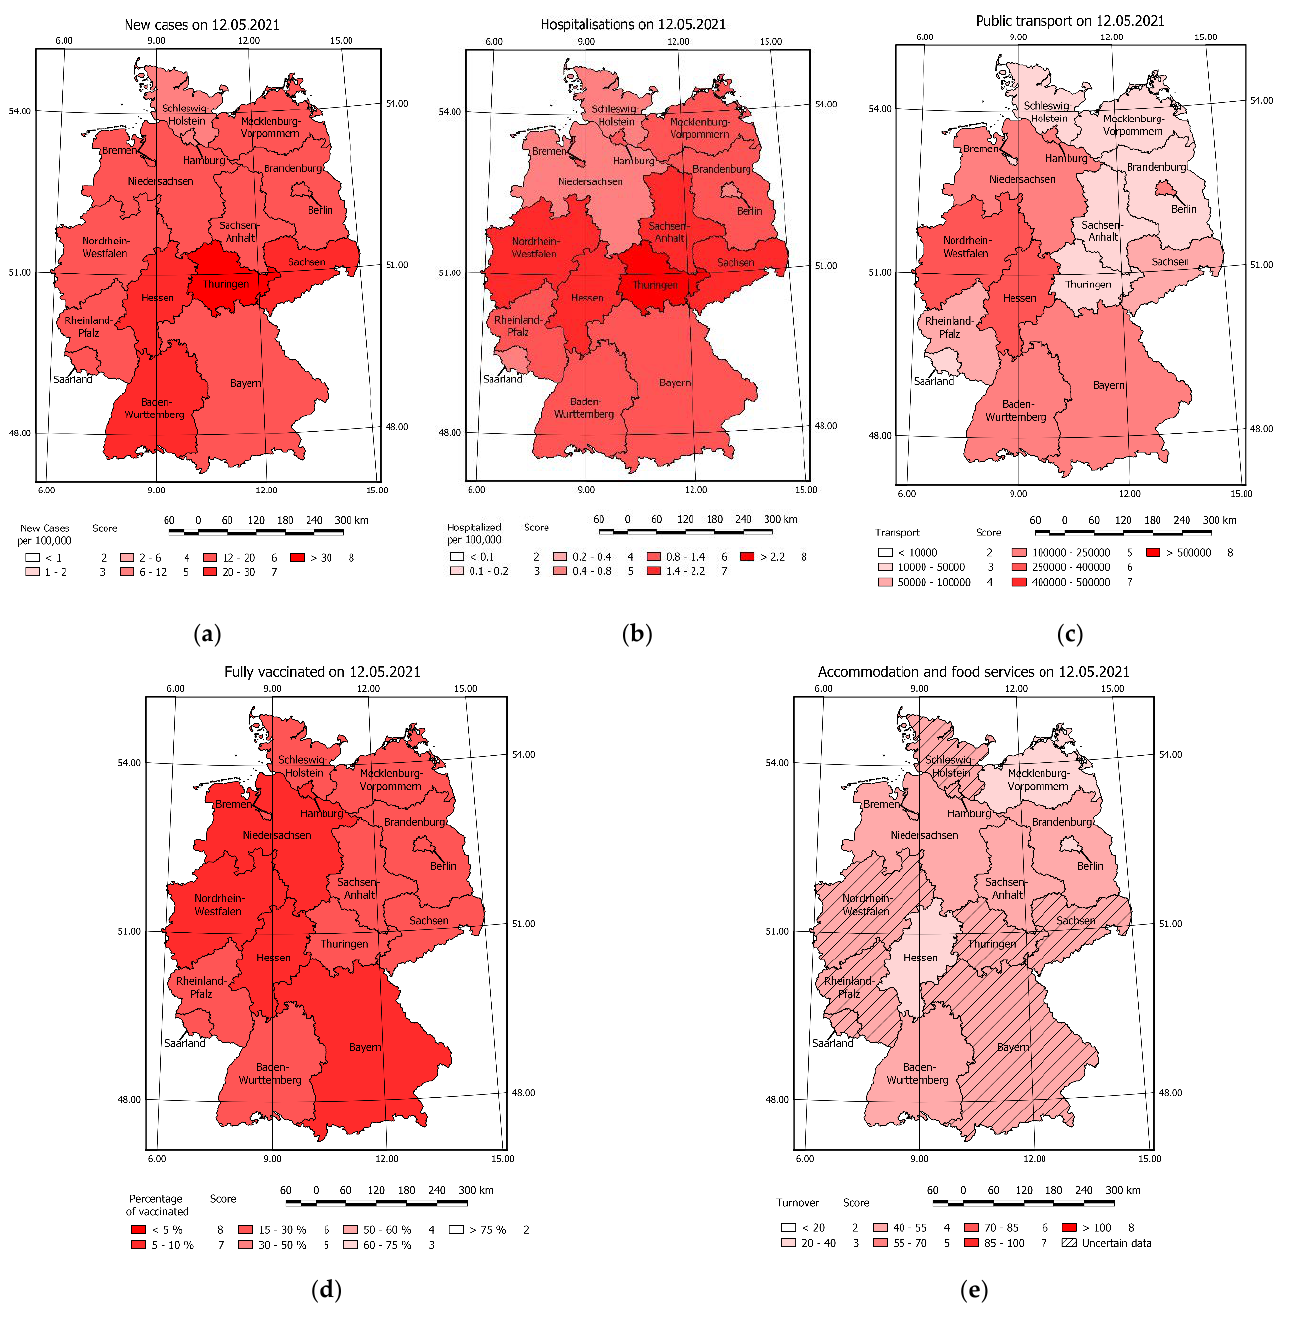
Figure 5. Maps of VSc for selected dynamic criteria on 12 May 2021 ( a ) new cases ( b ) hospitalisations ( c ) public transport ( d ) fully vaccinated ( e ) turnover from food and accommodation services.